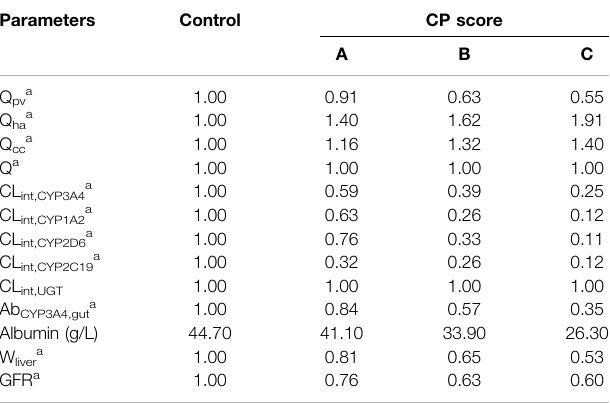
TABLE 1 | Physiological and biochemical parameter changes in the liver disease model according to CP score (A, B, C). Johnson ’ s reported values (Johnson et al., 2010).